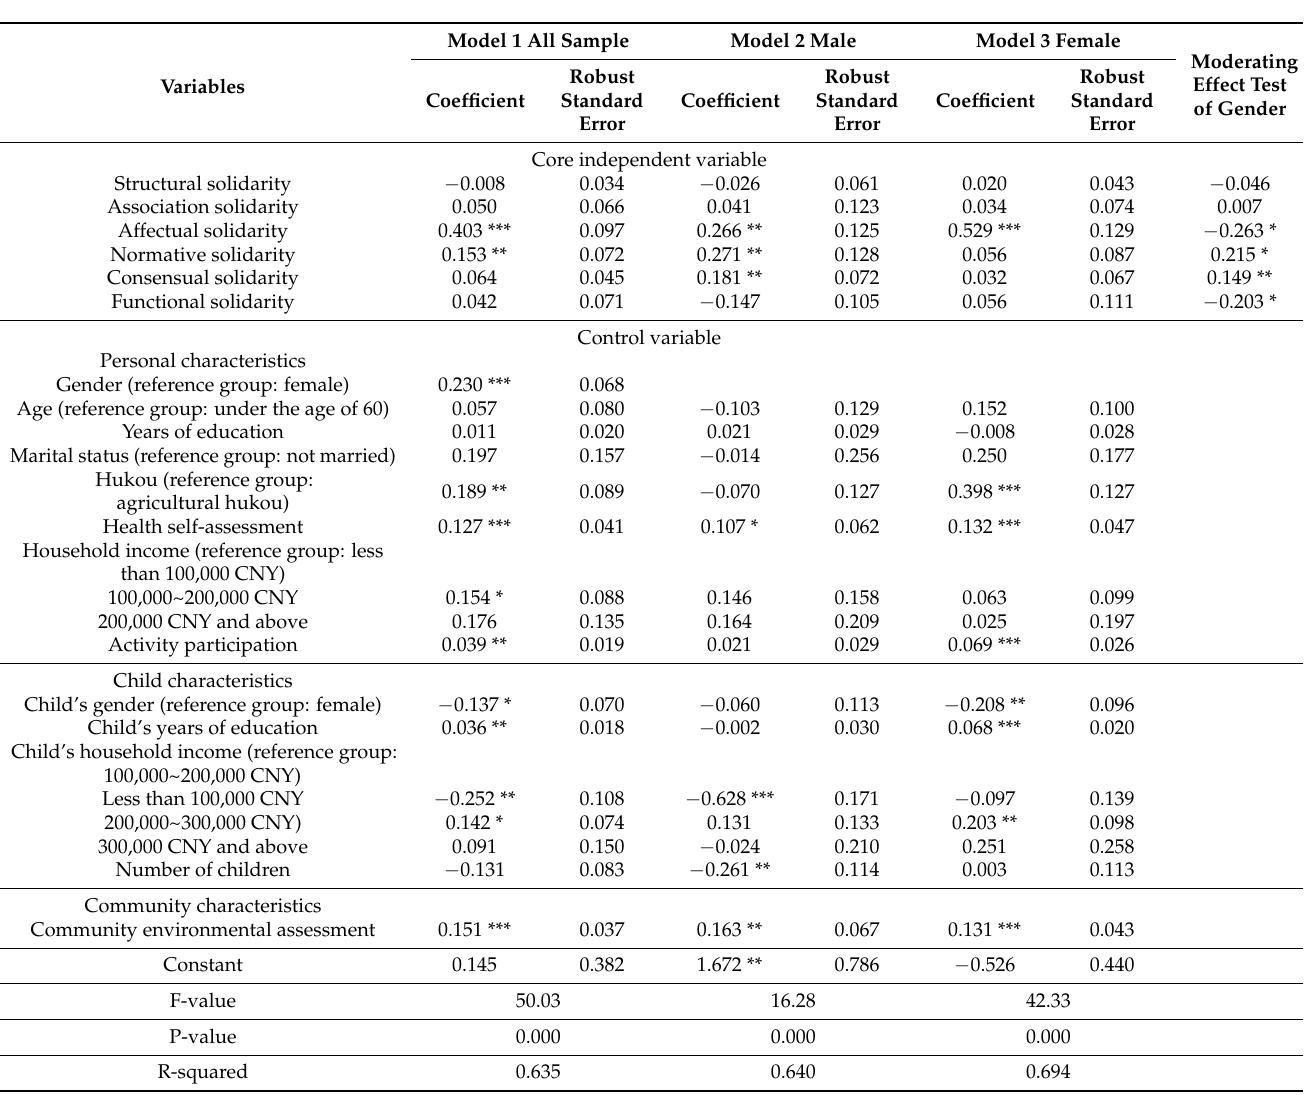
Table 4. Results of regression